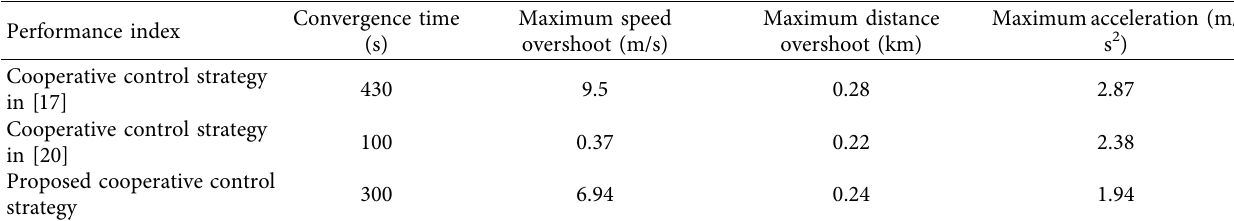
Figure 8: The simulation results of applying the proposed cooperative tracking control strategy, which dynamically adjusts the distance between adjacent trains when the desired speed changes. (a) The speed curves. (b) The distance between adjacent Table 4: The comparisons of four performance indices in three strategies.